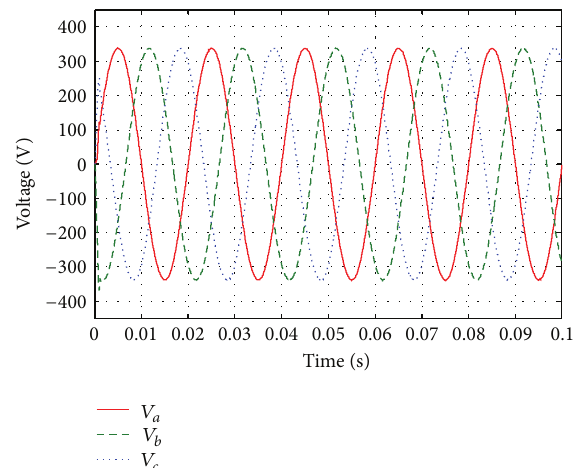
Figure 16: Output voltage waveforms (i.e., 𝑉 𝑎 , 𝑉 𝑏 , and 𝑉 𝑐 ) of the three-phase inverter with 𝑅𝐿 load.